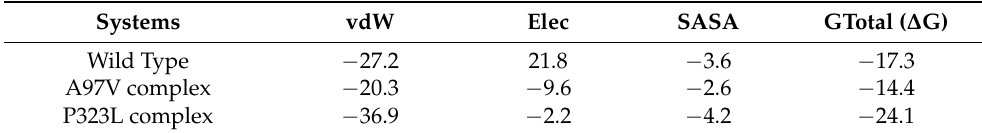
Table 1. Free energy of all the systems are calculated in